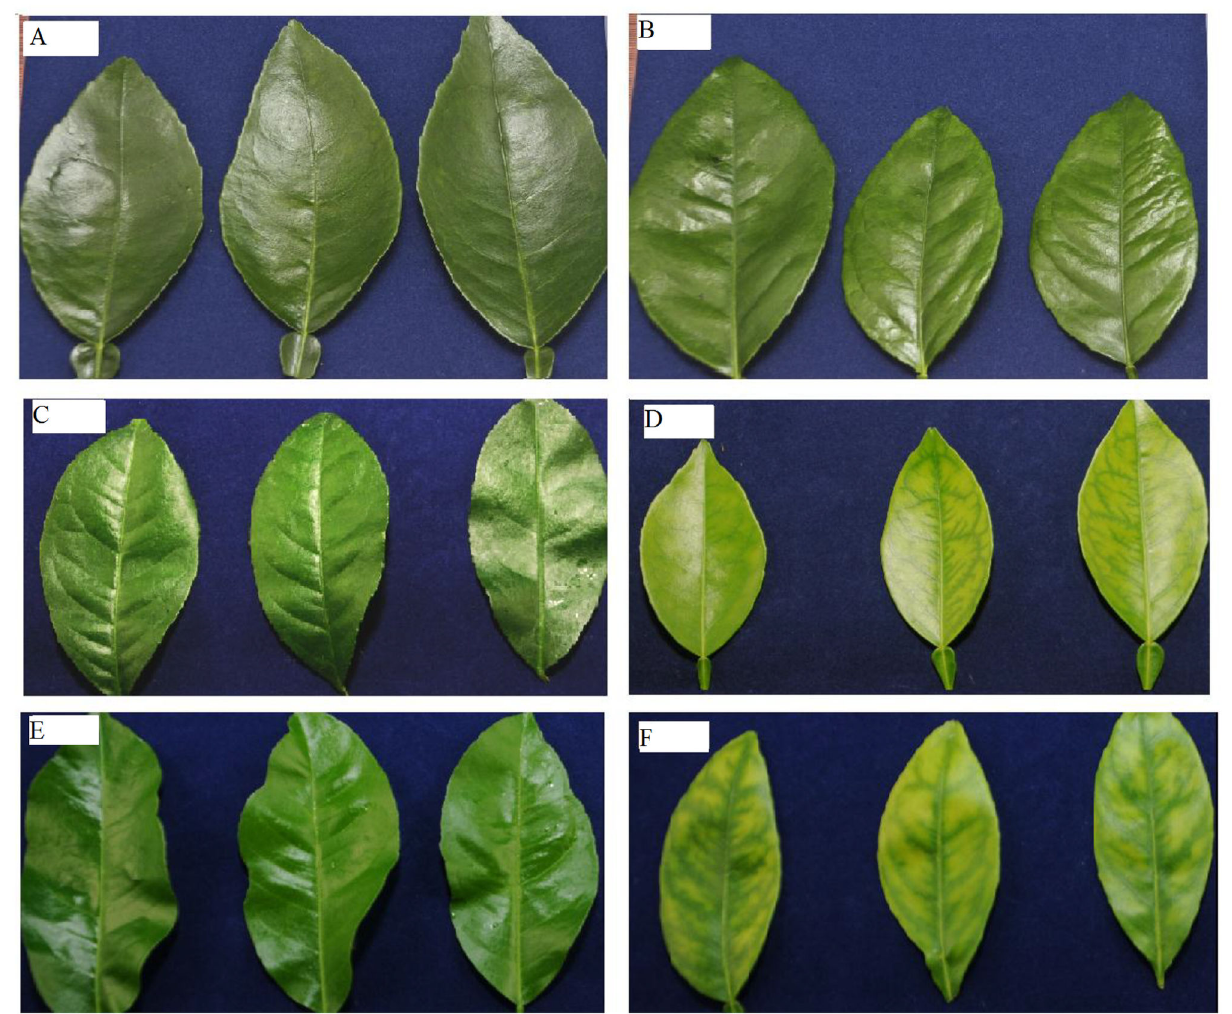
Figure 1. Progression of huanglongbing (HLB)-related symptoms in ‘ Candidatus Liberibacter asiaticus’-inoculated ‘Valencia’ sweet orange seedlings. A ) leaves from control plants 19 weeks after inoculation; B ) leaves from HLB-grafted plants 19 weeks after inoculation; C ) leaves from control plants 29 weeks after inoculation; D ) leaves from HLB-grafted plants 29